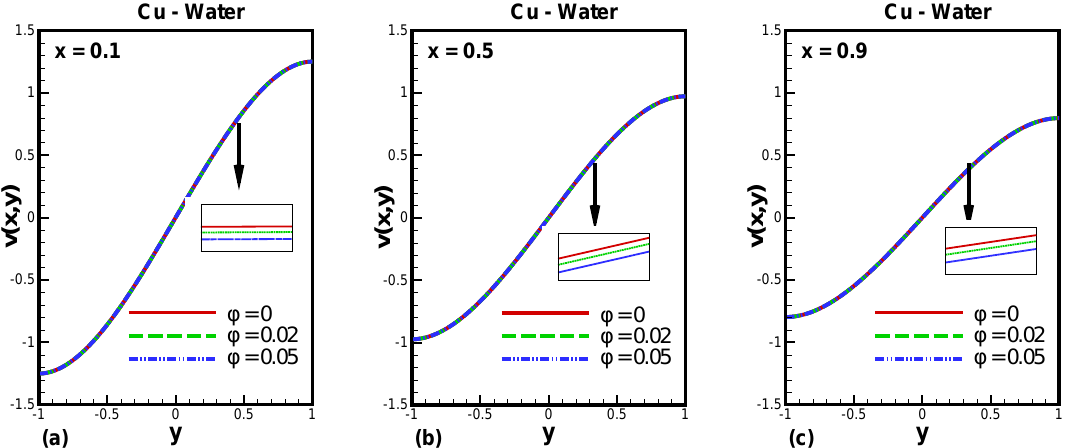
Figure 3. Effect of copper nanoparticle volume fraction φ on dimensionless transverse velocity at the ( a ) entrance, ( b ) middle, and ( c ) exit regions of the channel, when β = 0.5, δ = 0.2, R e = 1, and γ = 0.2. The effect of Cu-nanoparticles volume fraction φ on temperature profile θ ( x , y ) at the entrance, middle, and exit regions are shown in Figure 4. The increase in φ tends to increase the temperature profile at all three regions inside the channel. Moreover, the temperature profile at the entrance region is observed to be higher compared to the middle and exit regions of the channel. This happens due to leakage of fluid inside the channel, while addition of volume fraction enhances the temperature profile remarkably.